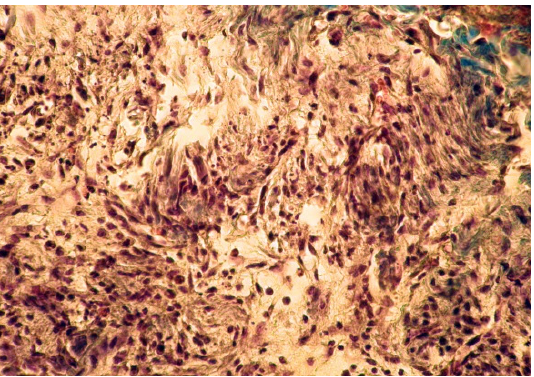
Figure 5. Group A. Buffer zone, consisting of fibroblast proliferation and collagen fiber synthesis. Col. Trichrome Masson, × 200.